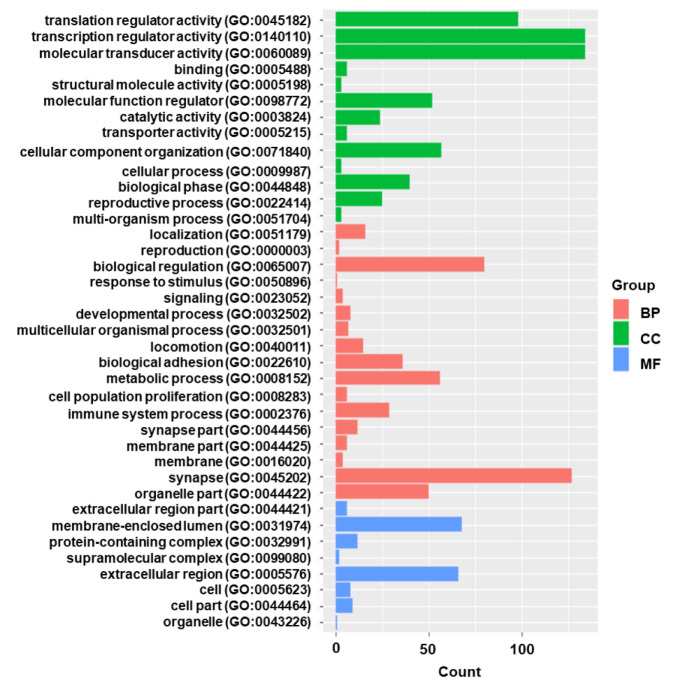
The gene functional classification of DEGs in HIV positive patients with TB compared with TB negative. BP, biological processes; CC, cellular compartment; MF, molecular function. Note that the most DEGs belonged to “catalytic activity” and “binding”.